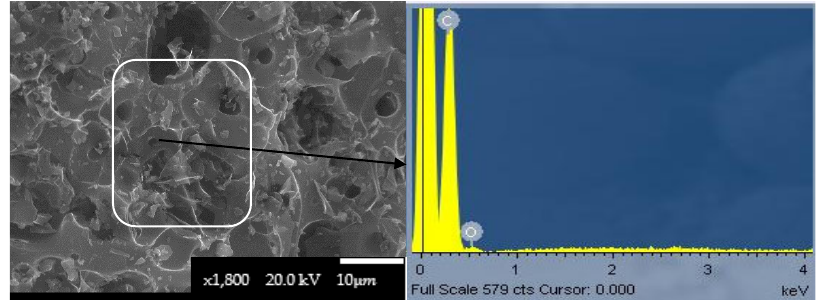
Figure 3. SEM image of ACK carbon with a magnification of 1800× and the corresponding EDS spectrum.